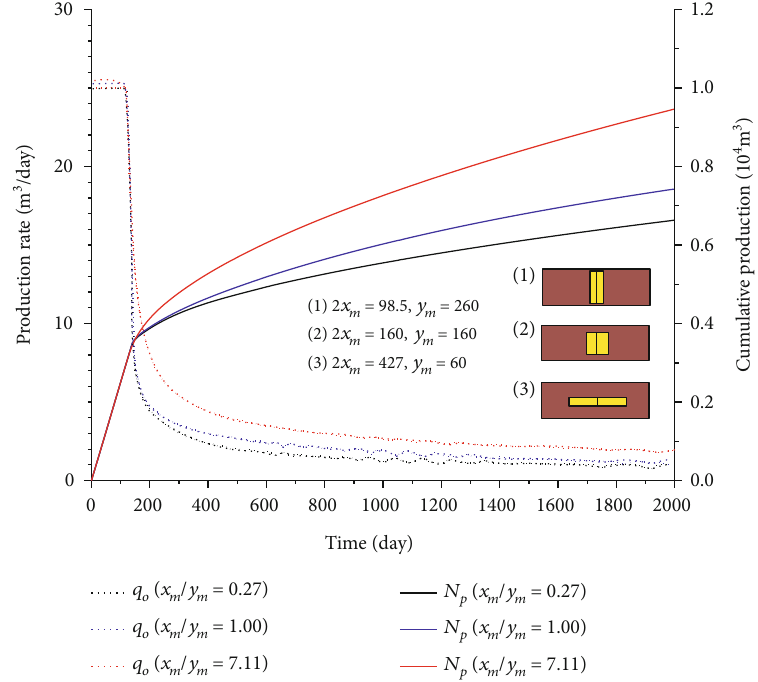
Figure 13: The e ff ect of SRV shape on fl ow rate and cumulative yield (compound working